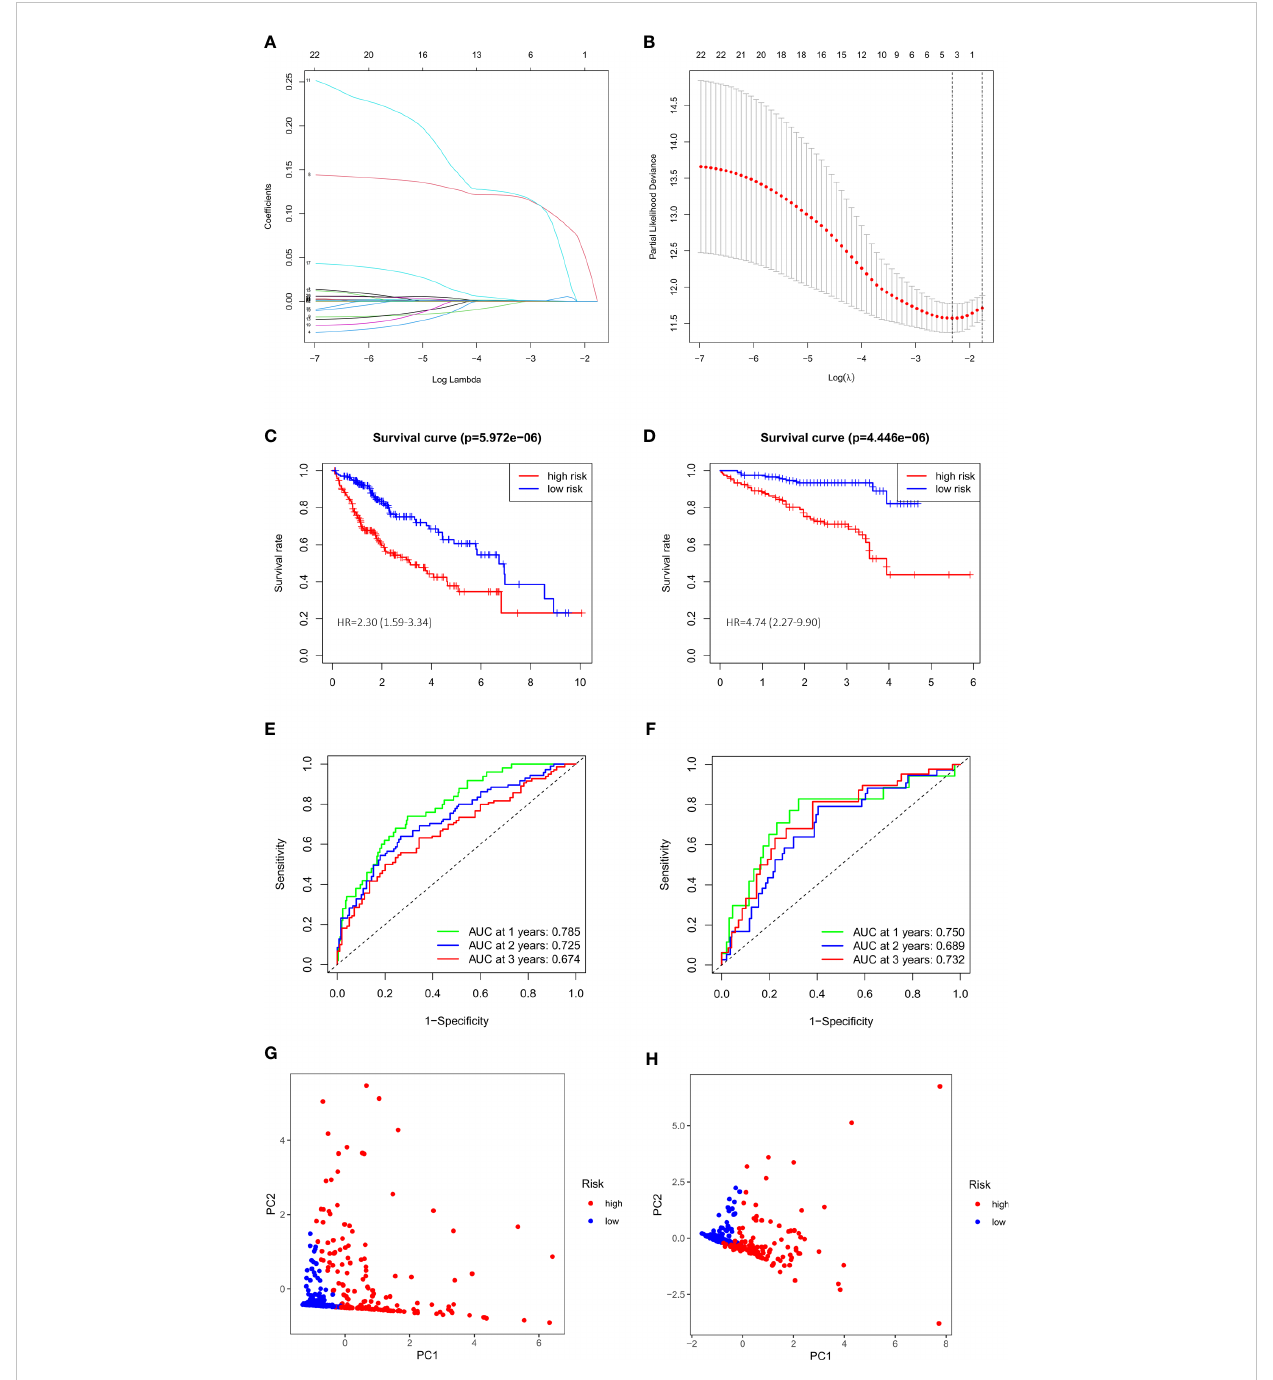
FIGURE 3 Evaluation and validation of 3-gene signature in TCGA cohort and ICGC cohort. (A) LASSO coef fi cient pro fi les of 23 prognostic genes of HCC. (B) LASSO regression with tenfold cross-validation found 4 prognostic genes using the minimum l . (C) Kaplan – Meier curves for OS in TCGA cohort. (D) Kaplan – Meier curves for OS in ICGC cohort. (E) Time-dependent ROC curves for OS in TCGA cohort. (F) Time-dependent ROC curves for OS in ICGC cohort. (G) PCA plot of risk score in TCGA cohort. (H) PCA plot of risk score in ICGC